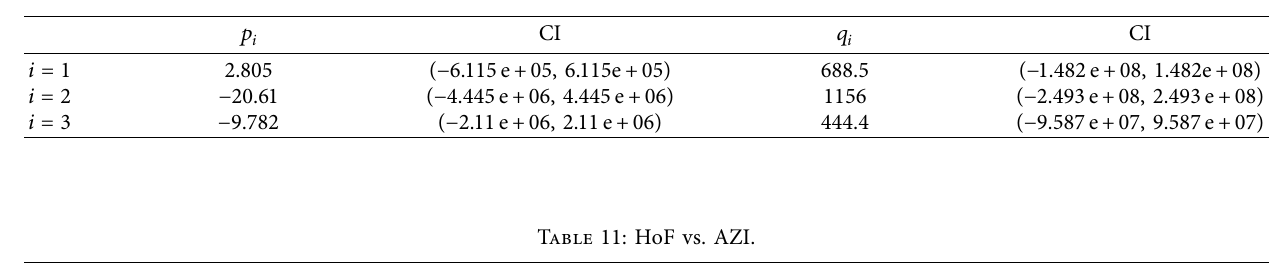
Table 10: HoF vs. F.